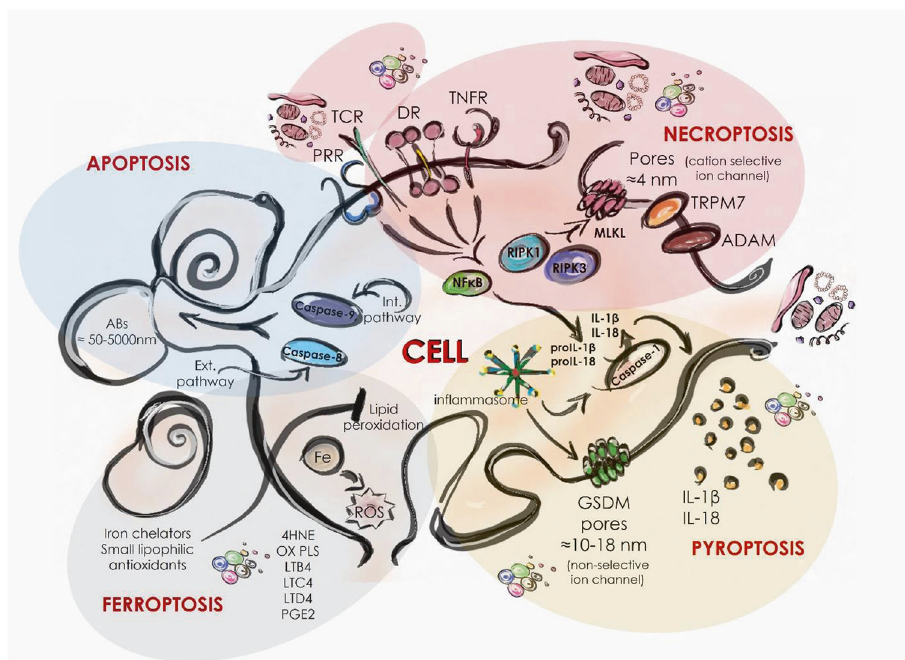
Fig. 2 Comparison of the main processes leading to DAMP release in apoptosis, necroptosis, pyroptosis and ferroptosis. During apoptosis, caspase-regulated events lead to the wrapping of intracellular components into apoptotic bodies. Subsequent efferocytosis prevents the release of DAMPs into the extracellular space. Necrosome induction results in the activation of cation-selective ion channels, leading to cell lysis due to osmotic shock. Pyroptosis is characterized by the secretion of IL-1 and IL-18 cytokines by in fl ammasome activation and the formation of voluminous non-selective pores formed by GSDMs. In ferroptosis, oxidative perturbations accumulate toxic lipid peroxides that ultimately cause the DAMP release. PRR Pattern Recognition Receptor DR death receptor, GSDM gasdermin, ADAM a disintegrin and metalloproteinase, TRPM7 Transient receptor potential cation channel, subfamily M, member 7, 4HNE 4-Hydroxynonenal, PGE2 Prostaglandin E 2, OX PLS oxidized glycerophospholipids, LTB4 Leukotriene B4, LTC4 Leukotriene C4, LTD4 Leukotriene D4, RIPK1 Receptor- interacting serine/threonine-protein kinase, MLKL Mixed lineage kinase domain-like